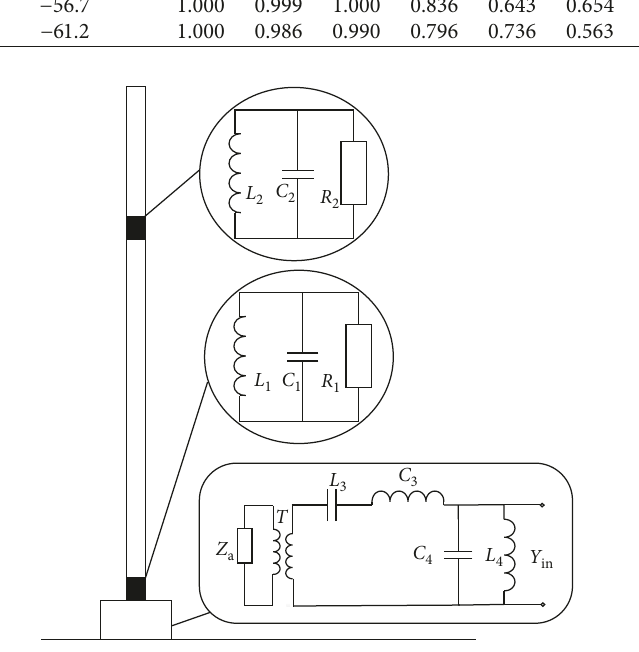
Figure 14: Antenna optimization diagram. Table 9: The element optimization values.